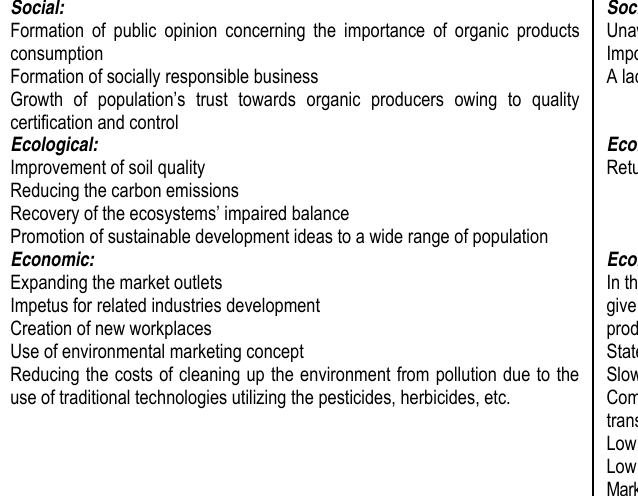
Table 1 (cont.). Results of the SWOT analysis of the Ukrainian organic products market development Social: Formation of public opinion concerning the importance of organic products consumption Formation of socially responsible business Growth of population’s trust towards organic producers owing to quality certification and control Ecological: Improvement of soil